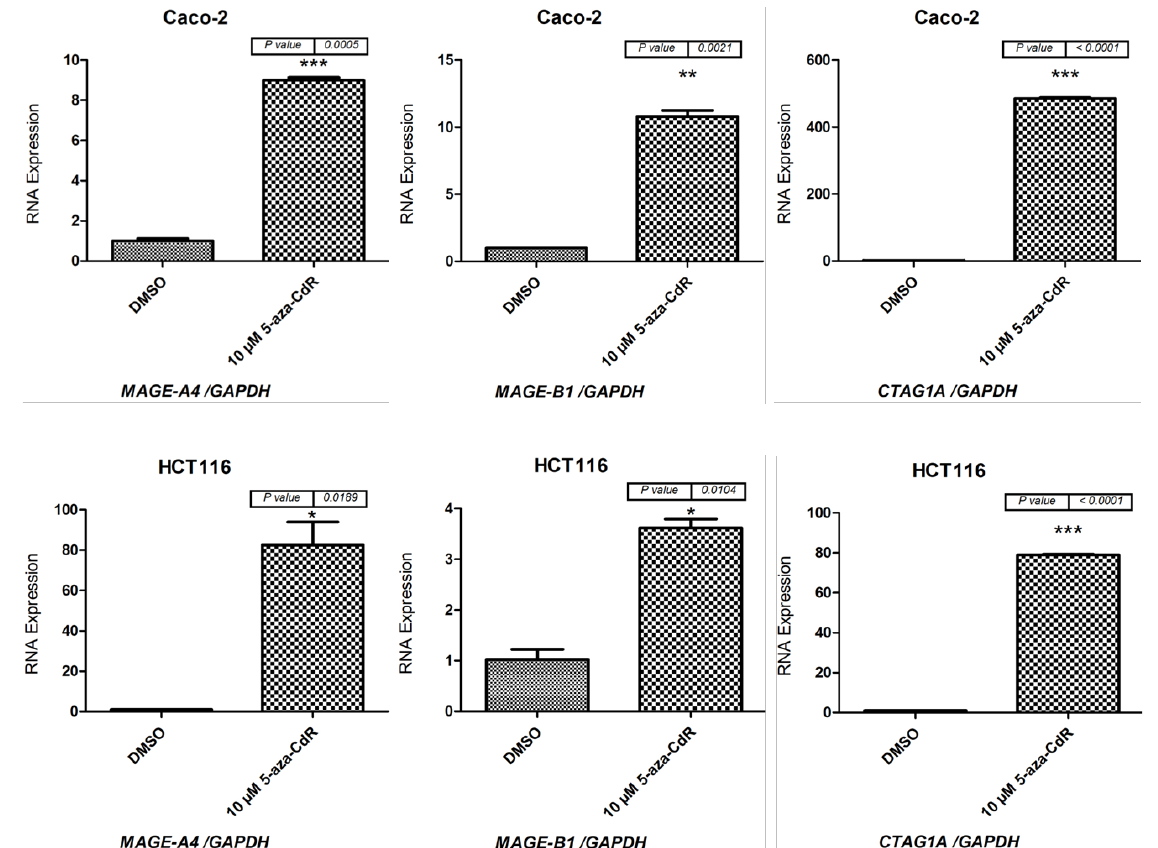
Figure 2. qRT-PCR analysis of MAGE-A4 , MAGE-B1 , and CTAG1A expression in Caco-2 and HCT116 cells following treatment with 10 μM 5-aza-CdR for 72 h. The bar charts illustrate the expression of MAGE-B1 , MAGE-A4 , and CTAG1A before and after 5-aza-CdR treatment in Caco-2 cells (upper panel) and HCT116 cells (lower panel). The expression levels were normalized to GAPDH mRNA levels. The error bars represent the standard error of the mean for three replicates for each gene. * p ≤ 0.05, ** p ≤ 0.01, *** p ≤ 0.001.